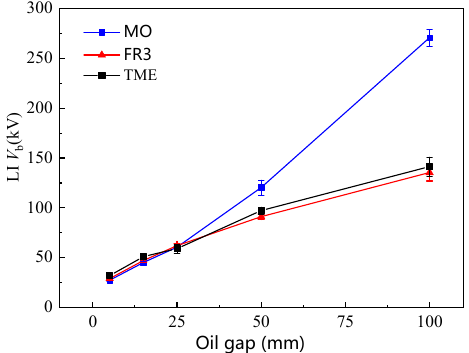
Figure 9. The impulse breakdown voltage at different oil gaps.